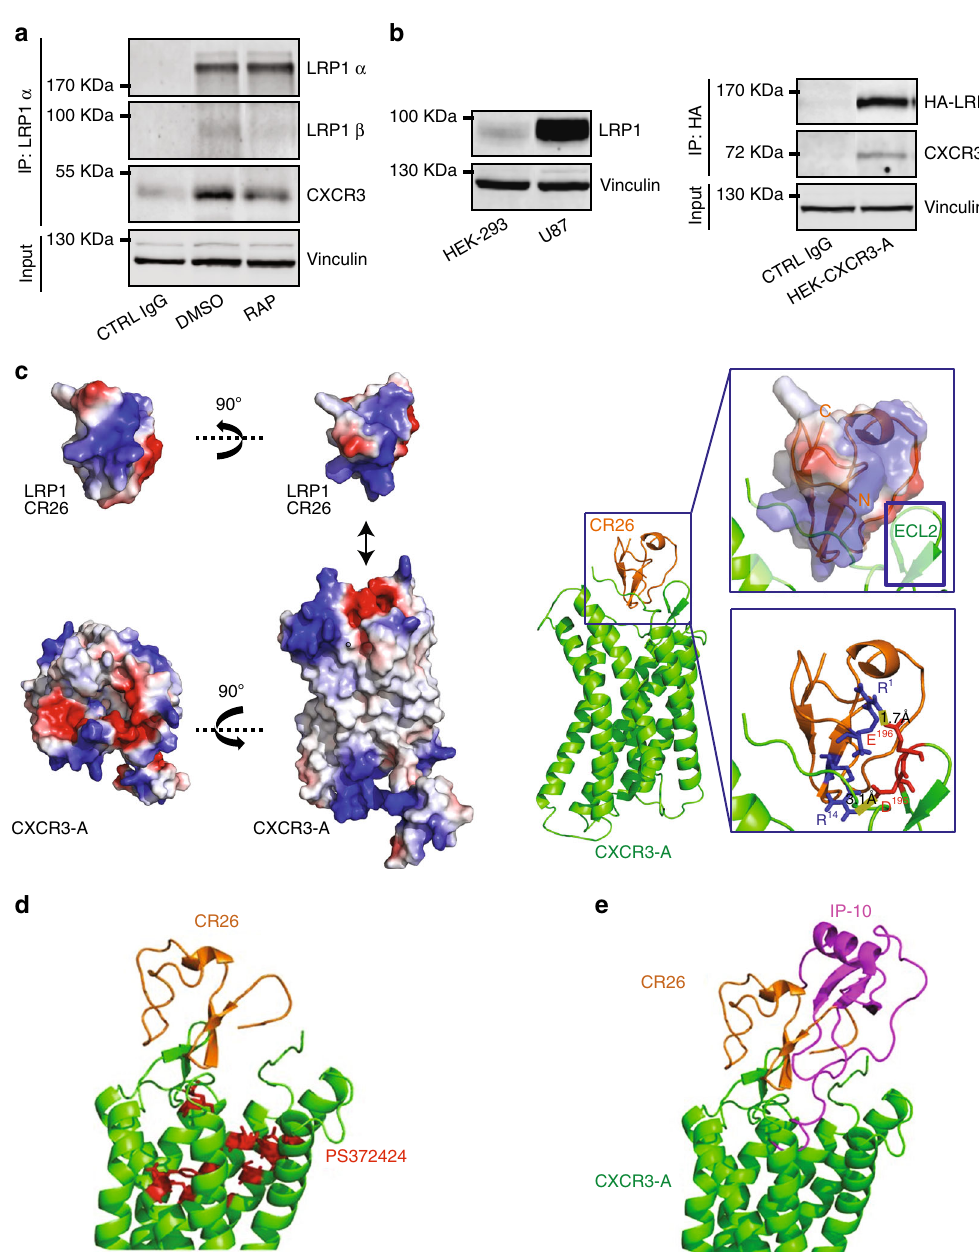
Fig. 4 Interaction domain and modeling of CXCR3:LRP1 complex. a Immunoprecipitation against LRP1 (IP LRP1 α , antibody 8G1) and western blot of the CXCR3:LRP1 complex (antibody 8G1 for LRP1 α and 2703-1 for LRP1 β ) in U87-CXCR3-A cells pretreated or not with the LRP1 antagonist RAP. DMSO negative control. b LRP1 protein expression in HEK-293 and U87 cells (antibody 2703-1 for LRP1 β ) (left panel). Immunoprecipitation for the mini-LRP1 carrying domain IV (HA-LRPIV) in HEK-CXCR3-A cells transfected with the pCDNA.3 HA-LRPIV vector (right panel). The experiments have been repeated three times with identical results. c Binding orientation of CXCR3-A and LRP1-CR26 according to their electrostatic potentials. Red: negative charge and blue: positive charge (left panel). Docking model for ECL2 of CXCR3 and CR26 of LRP1 (right panel). d and e Structural interaction model of CXCR3-A and its ligand PS372424 ( d ) and CXCL10 ( e